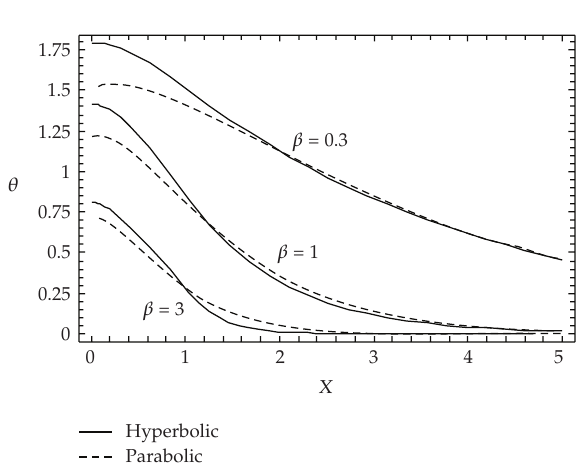
Figure 3: Dimensionless temperature distributions at η (cid:5) 1 for the heat source of constant strength and various values of β ; φ (cid:3) η (cid:4) (cid:5) 1 ,ψ 0 (cid:5) 1 , and U (cid:5) 0 . 1 .